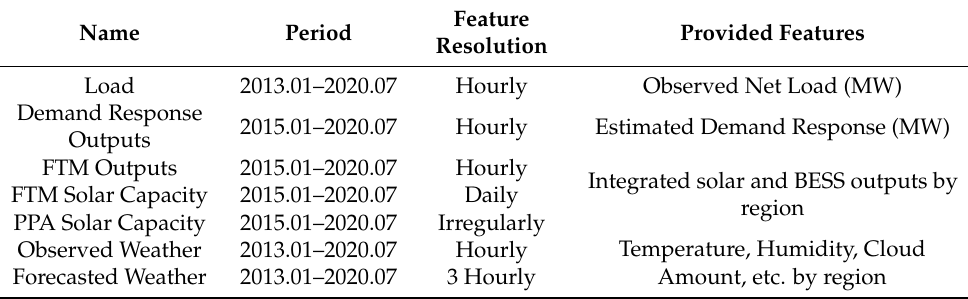
Table 4. Data Resources for BTM Capacity Estimation and Day-Ahead Load